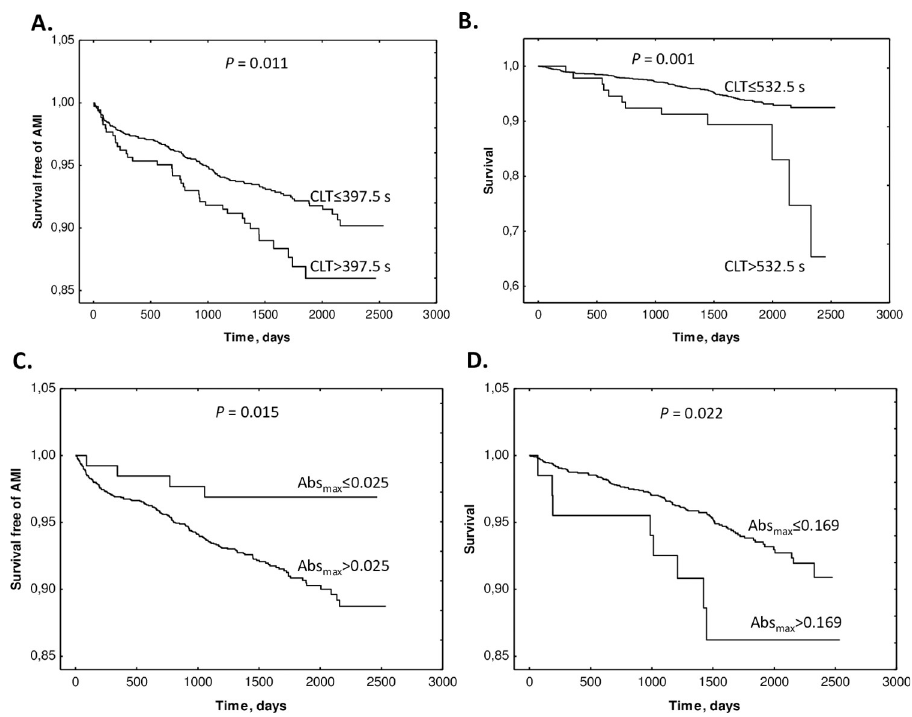
Fig 1. Kaplan-Meier analysis of outcome events according to CLT and Abs max cutoffs. A. Survival free of AMI in CLT group 0 (CLT � 397.5 s) and group 1 (CLT > 397.5) vs . time (days). B. Survival without mortality in CLT group 0 (CLT � 532.5 s) and group 1 (CLT > 532.5 s). C. Survival free of AMI in Abs max group 0 (Abs max � 0.025) and group 1 (A max > 0.025) vs . time (days). D. Survival without mortality in Abs max group 0 (Abs max � 0.169) and group 1 (Abs max >